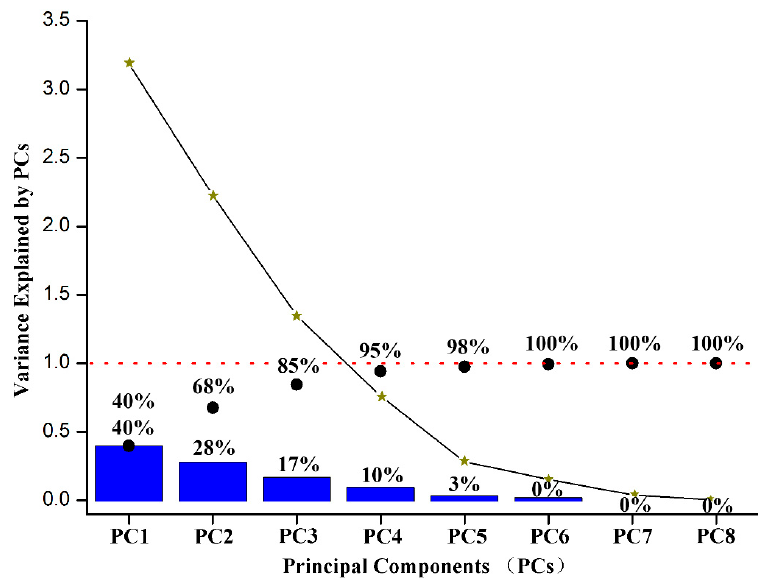
Figure 2. The principal components (PCs) with individual variances. The accumulated contributions of each PCs are represented with black dots, while the solid line depicts the eigenvalue.